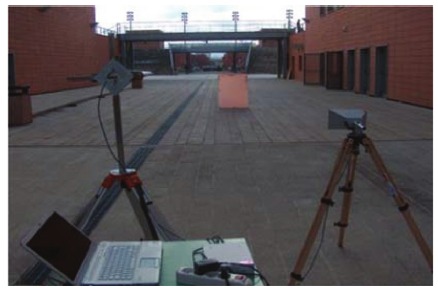
Figure 7: Photograph of outdoor test setup.